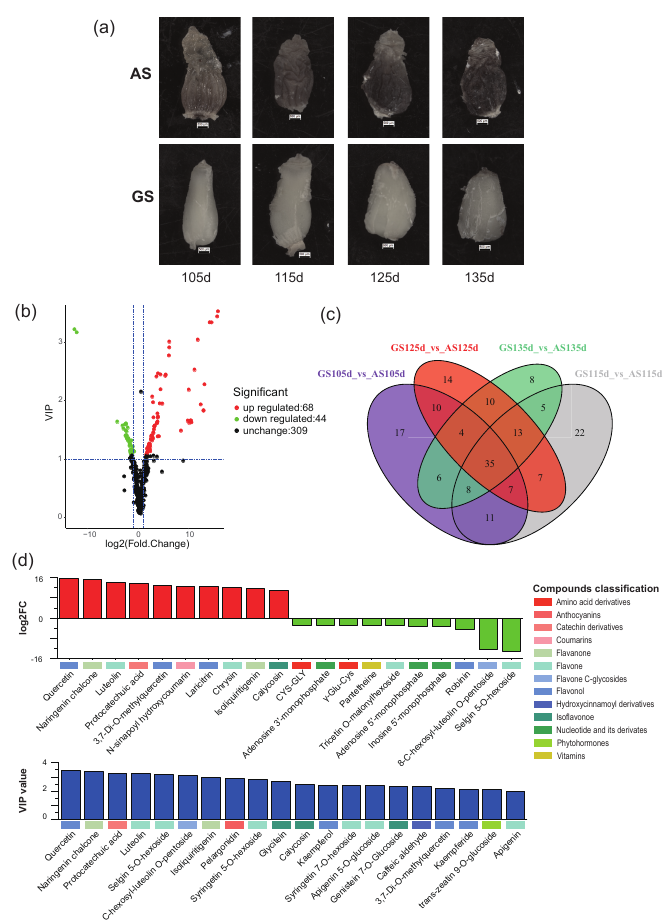
Figure 1. Microscopic observation of astringent seed / germinable seed (AS / GS) and major profiling of metabolites. ( a ) From 105d to 135d, the AS wrinkled and darkened on the surface, whereas the GS showed normal growth. ( b ) The variable importance in project (VIP) and log 2 FC values of all the metabolites were displayed in the volcano diagram with the red dots represented the up-regulated metabolites, the greed dots represented the down-regulated metabolites, while the black dots represent the metabolites showed no significant di ff erence between AS and GS. ( c ) The numbers of overlapping and stage-specific di ff erential metabolites from the four stages were showing in the Venn diagram. ( d ) The top 20 metabolites with the highest log 2 FC or VIP value were exhibited in the histogram with the classification of each metabolite was marked in di ff erent colors under the corresponding